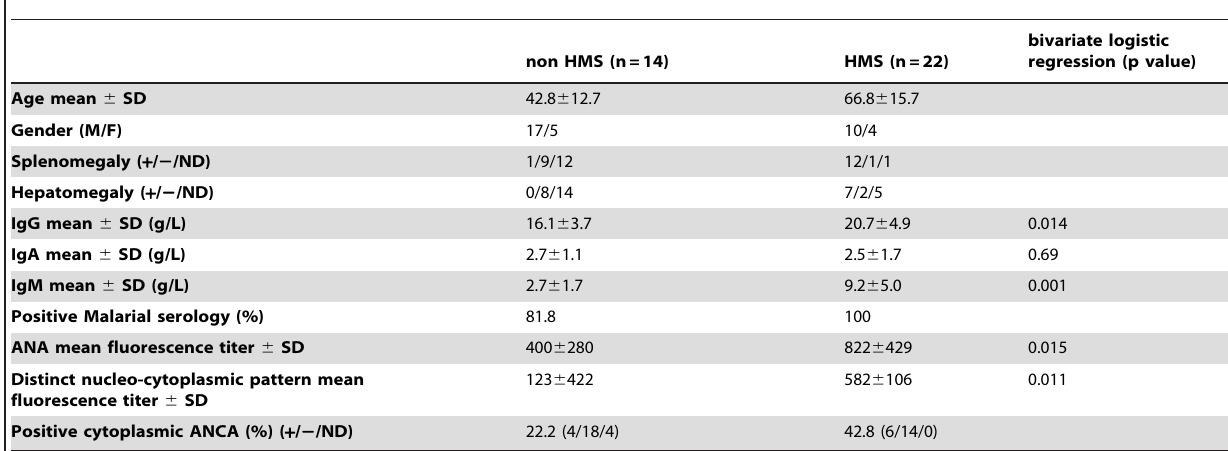
Table 2. Patients with malaria: Clinical and biological